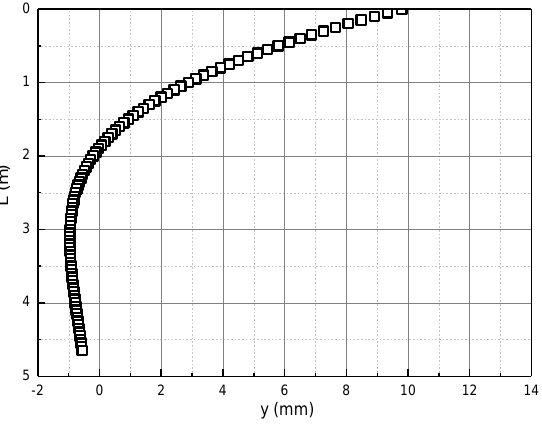
Figure 5. Horizontal displacement of pile body.